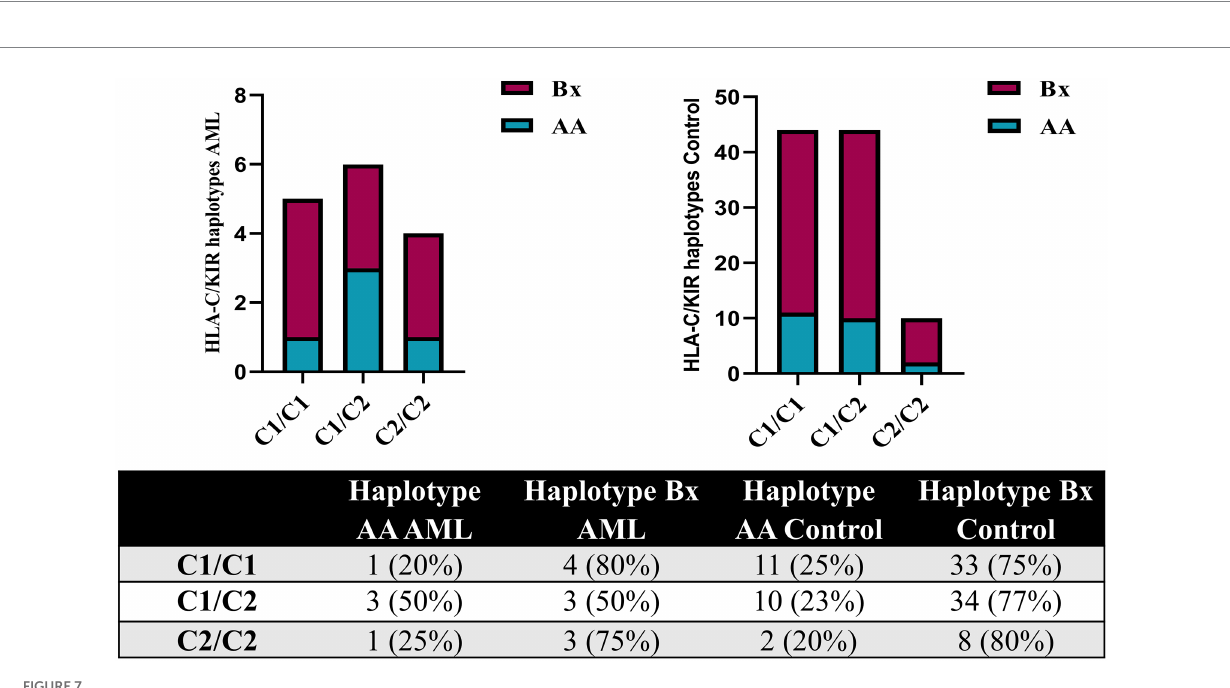
FIGURE 7 Combined HLA-C – KIR haplotypes in AML and healthy control individuals. Bars represent the number of (left) AML ( n = 15) and (right) healthy control ( n = 98) cases based on their HLA-C group (columns) and KIR haplotype (AA, blue; Bx,